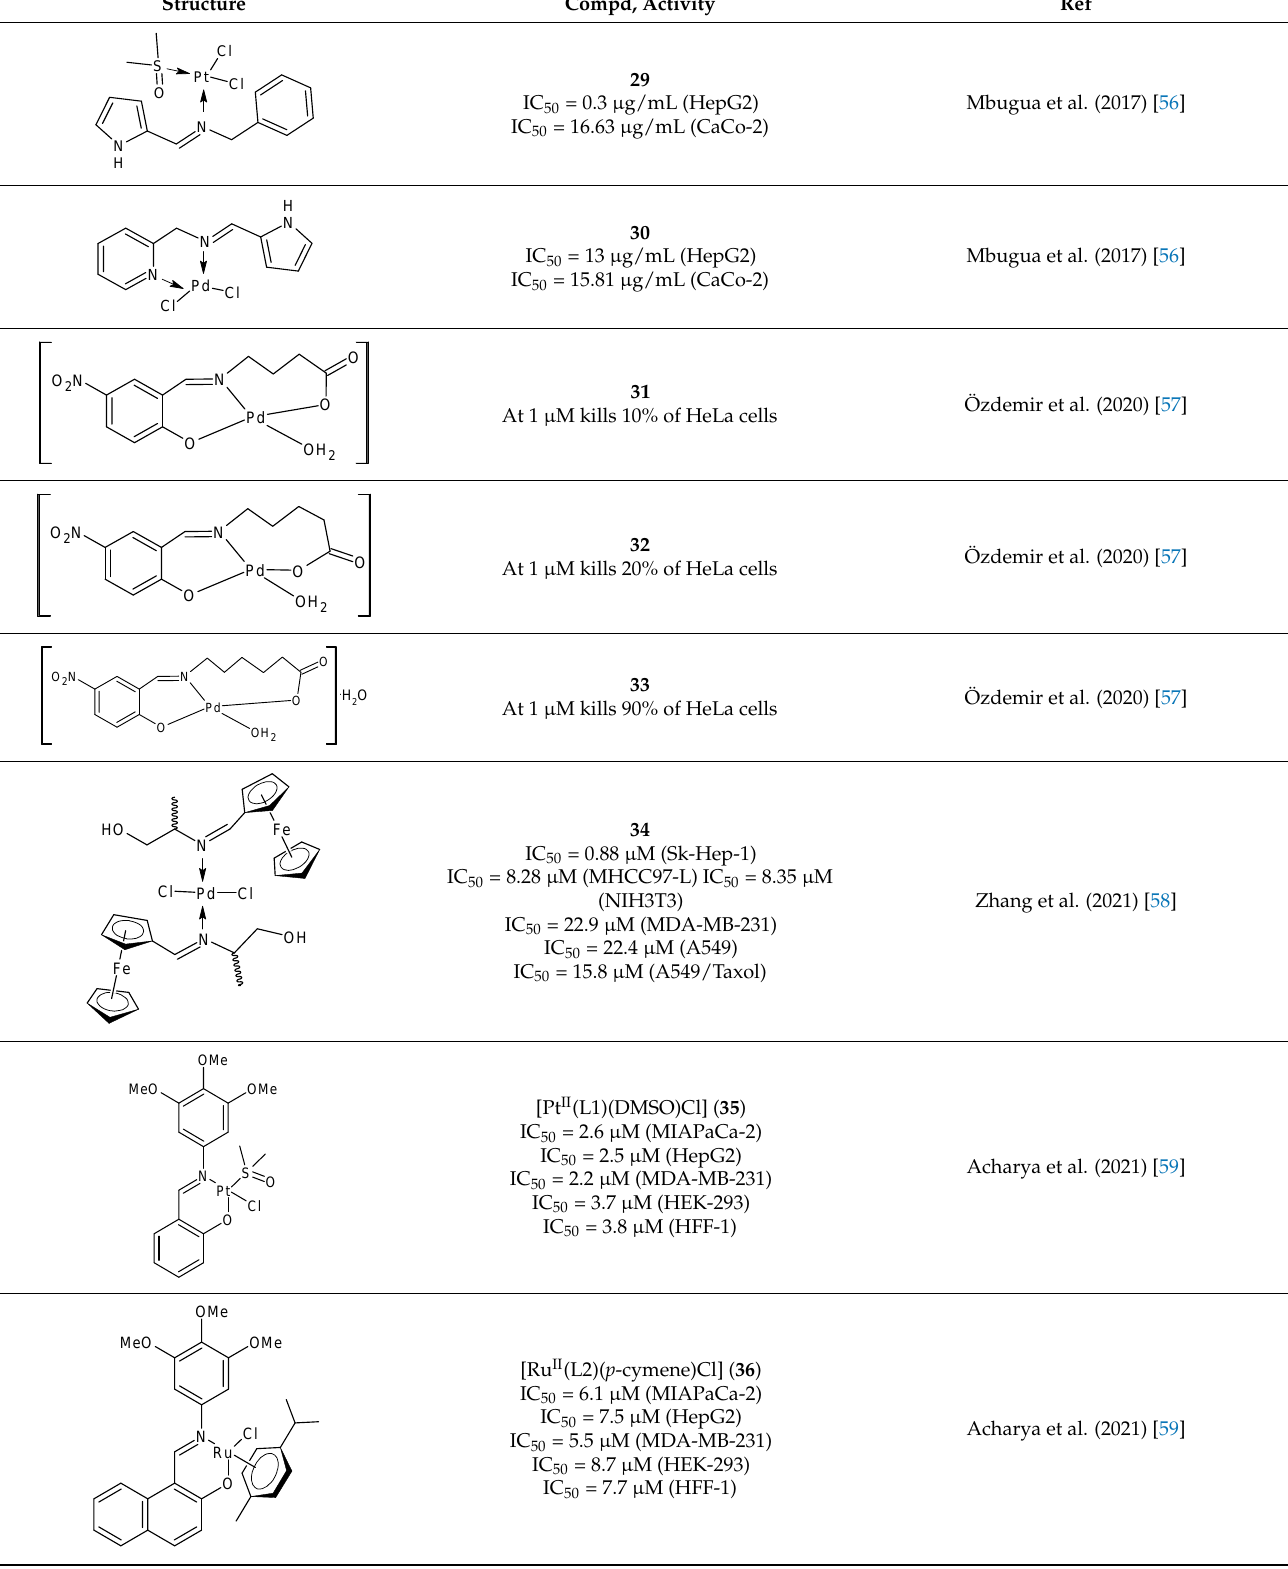
Table 2. Antiproliferative activity of Schiff base complexes with platinum group metals (PGM).